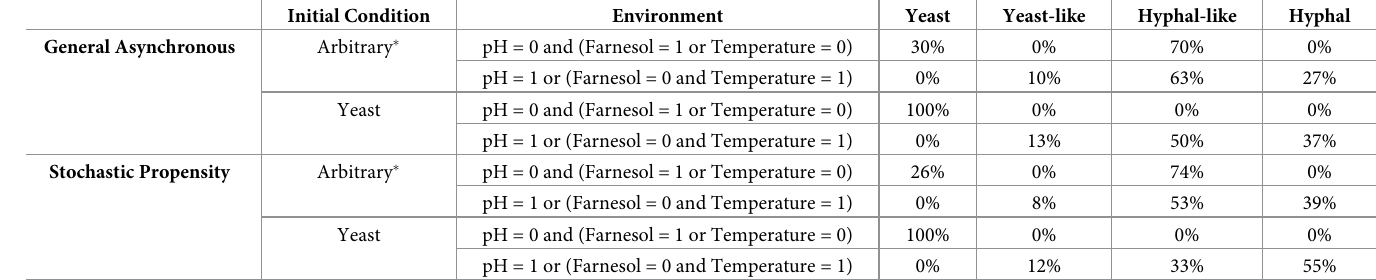
Table 2. The probability of converging to each attractor from an arbitrary initial state with hyphal_initiation = 0 and hyphal_maintenance = 0, or from a yeast state. While three attractor groups are stable in any environment, their reachability depends on the environment and on the initial state. For example, in a yeast-favoring environment (first row), if the system starts in a yeast state, it will remain in that state. The results are qualitatively the same whether general asynchronous update (top) or stochastic propensity update (bottom) is